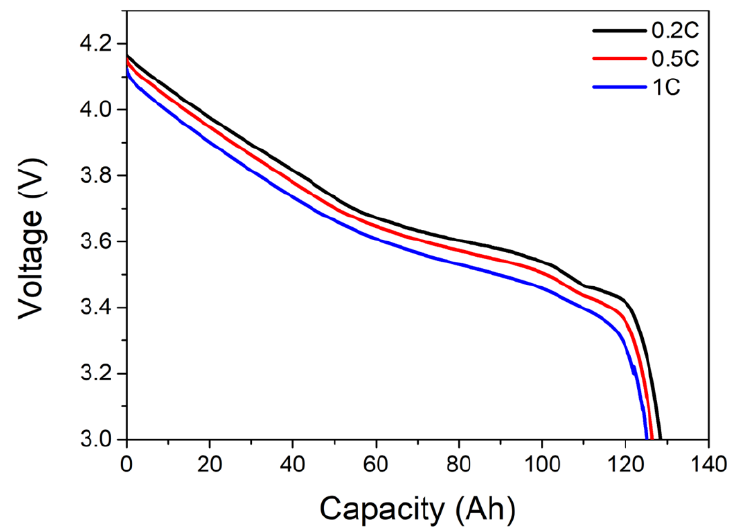
Figure 3. Experimental discharge voltage curves of 1st LIB strand for 0.2 C, 0.5 C, and 1 C.